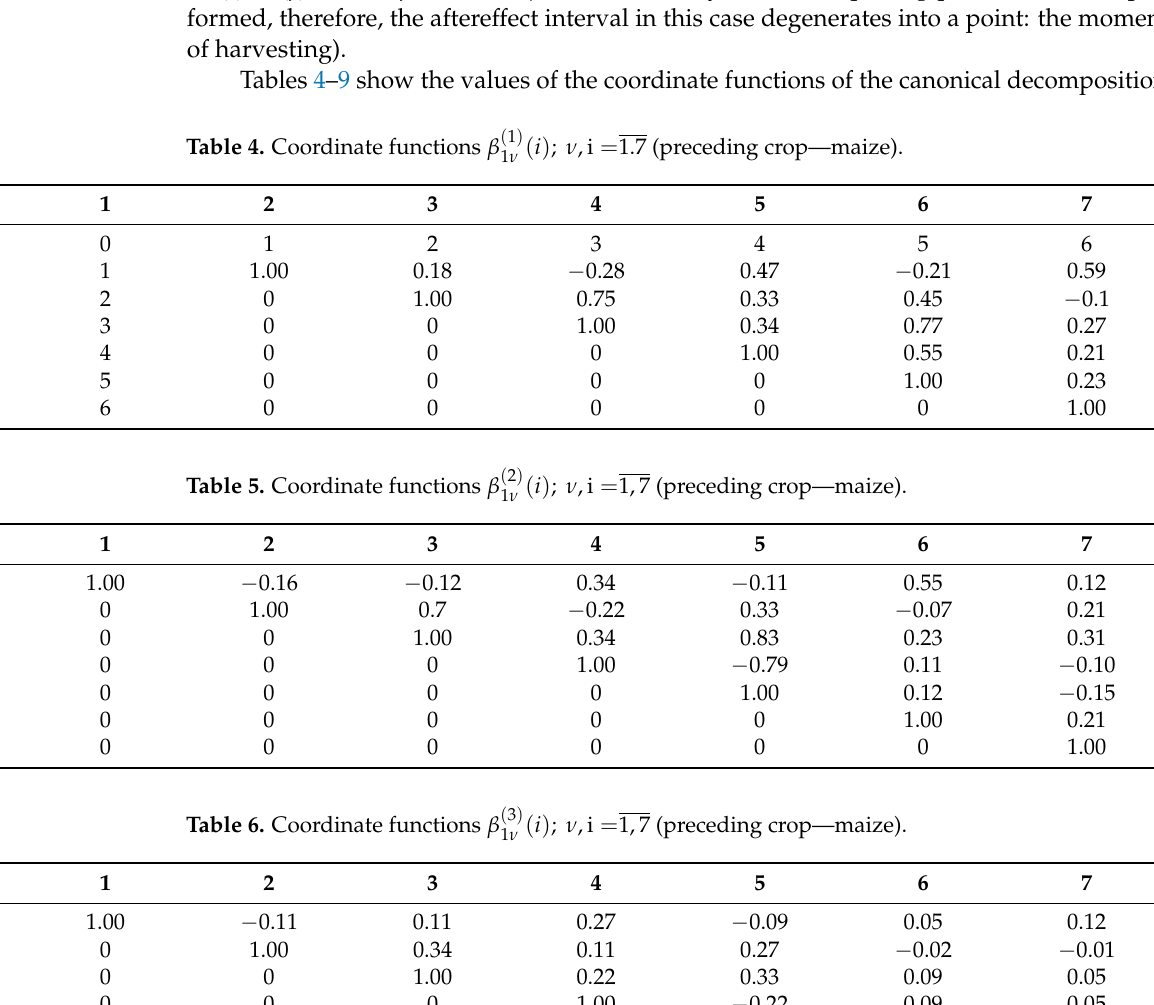
( 1 ) ( i ) ; ν ,i = 1,7 (preceding 1 ν